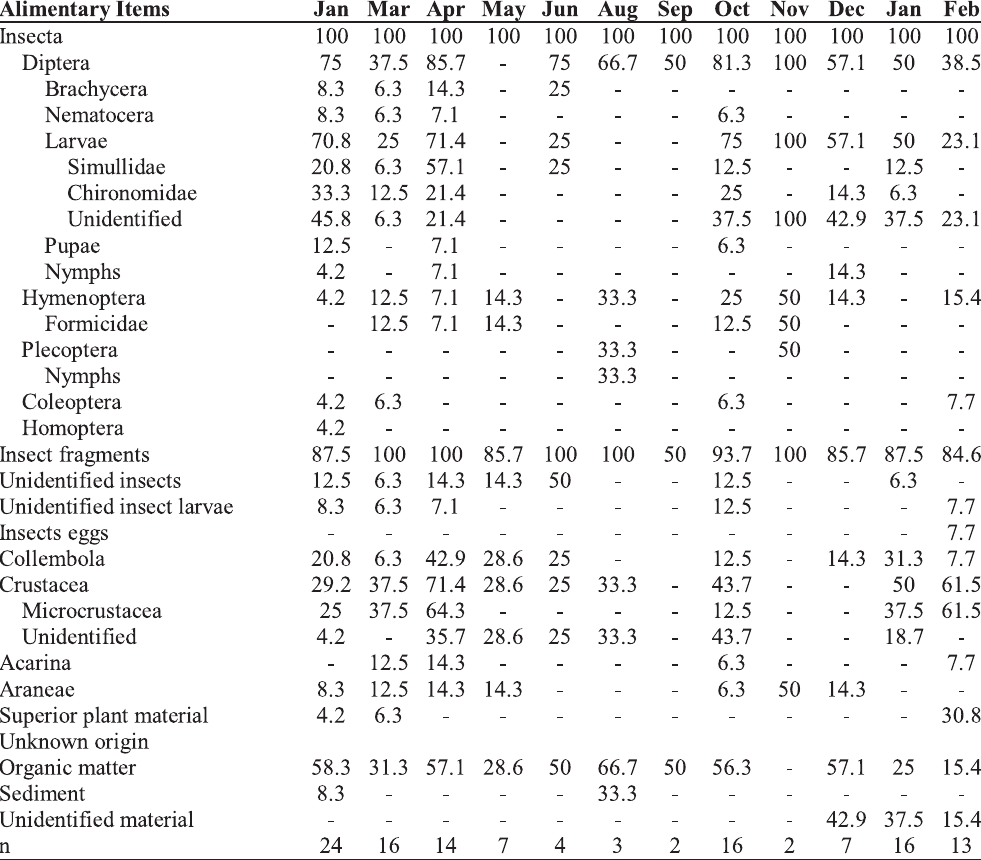
Table 2. Frequency of occurrence of the dietary items found in the stomachs of Mimagoniates rheocharis in Station 2 (n = number of examined